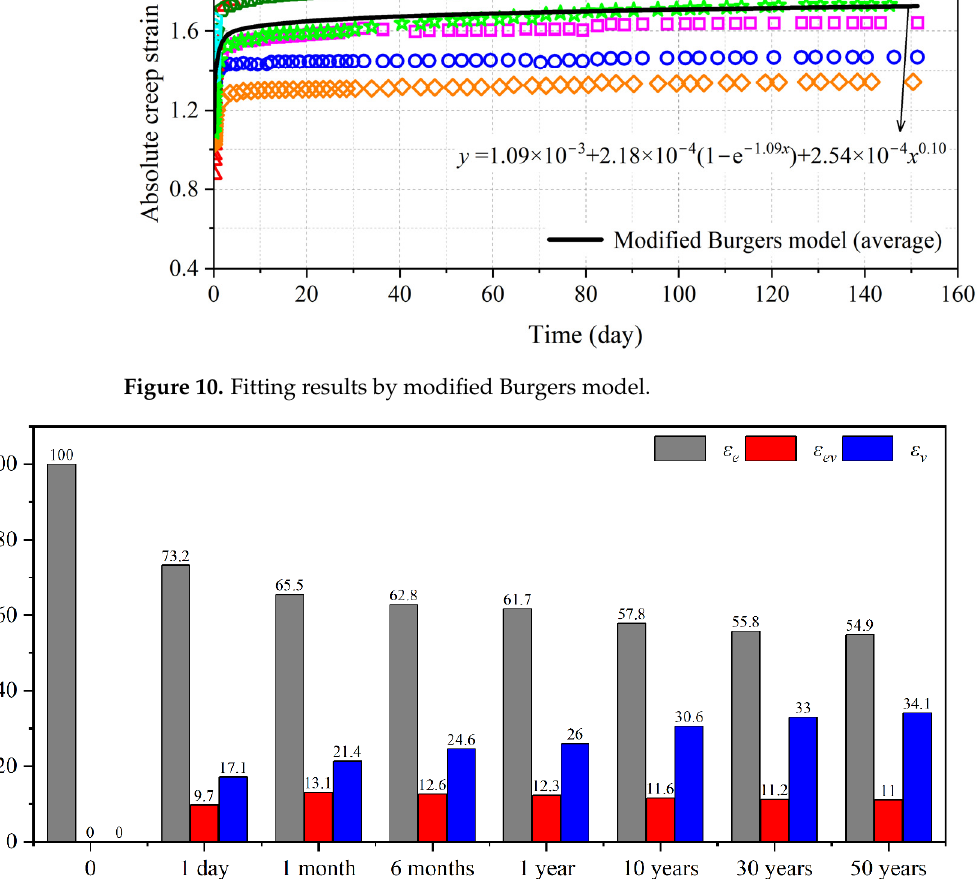
Figure 10. Fitting results by modified Burgers model .